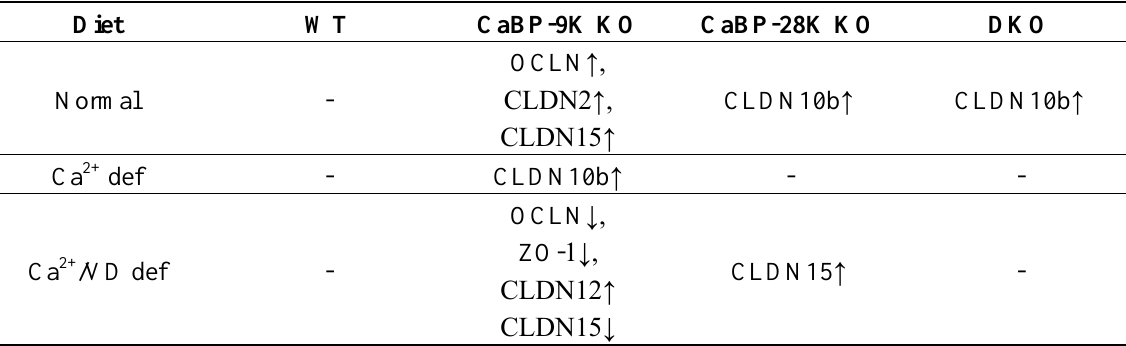
Table 2. Tight junction gene regulation in the